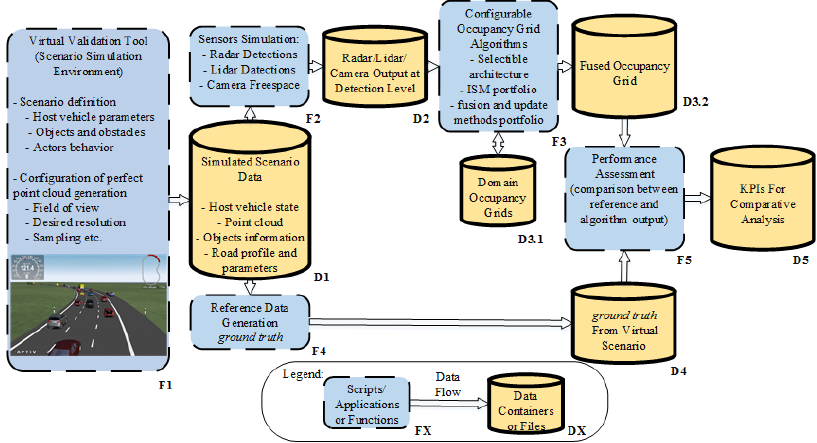
Figure 6. The Framework Schematics and Data